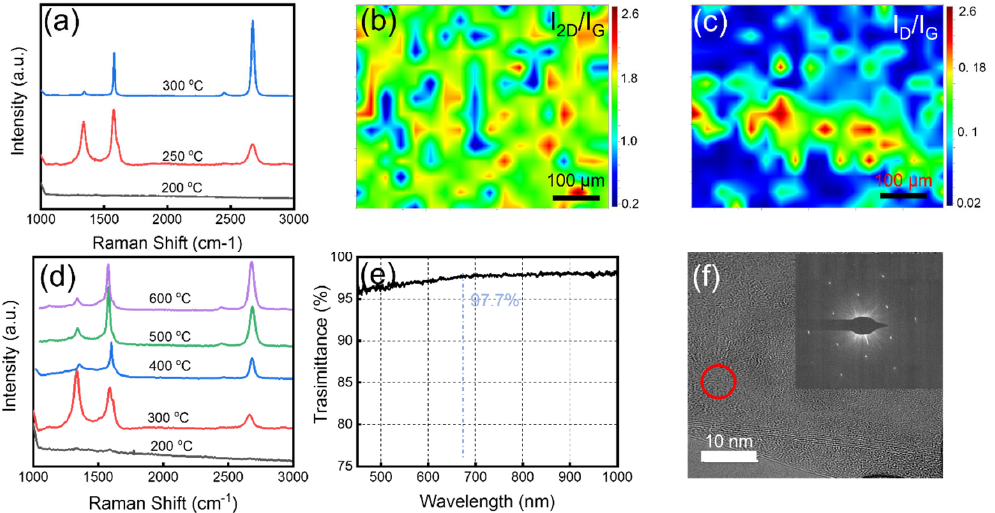
Figure 2. ( a ) Raman spectra of graphene grown at 200 °C, 250 °C and 300 °C. ( b , c ) Raman mapping images of I 2 D / I G and I D / I G of the graphene fi lm. The measurement area is 500 µm × 500 µm. ( d ) Raman spectra of graphene grown at di ff erent temperatures without gradient temperature. ( e ) The transmi tt ance of the obtained graphene fi lm. ( f ) TEM image and corresponding SAED pa tt ern of the graphene fi lm.